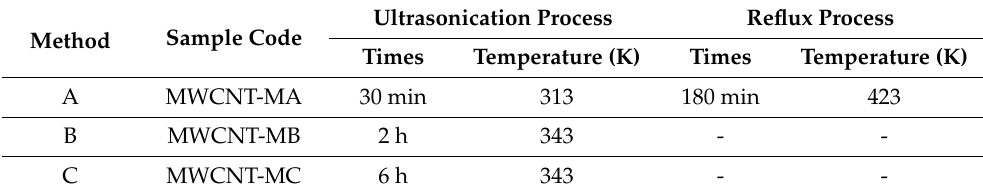
Table 1. Summary of three (3) acid treatment